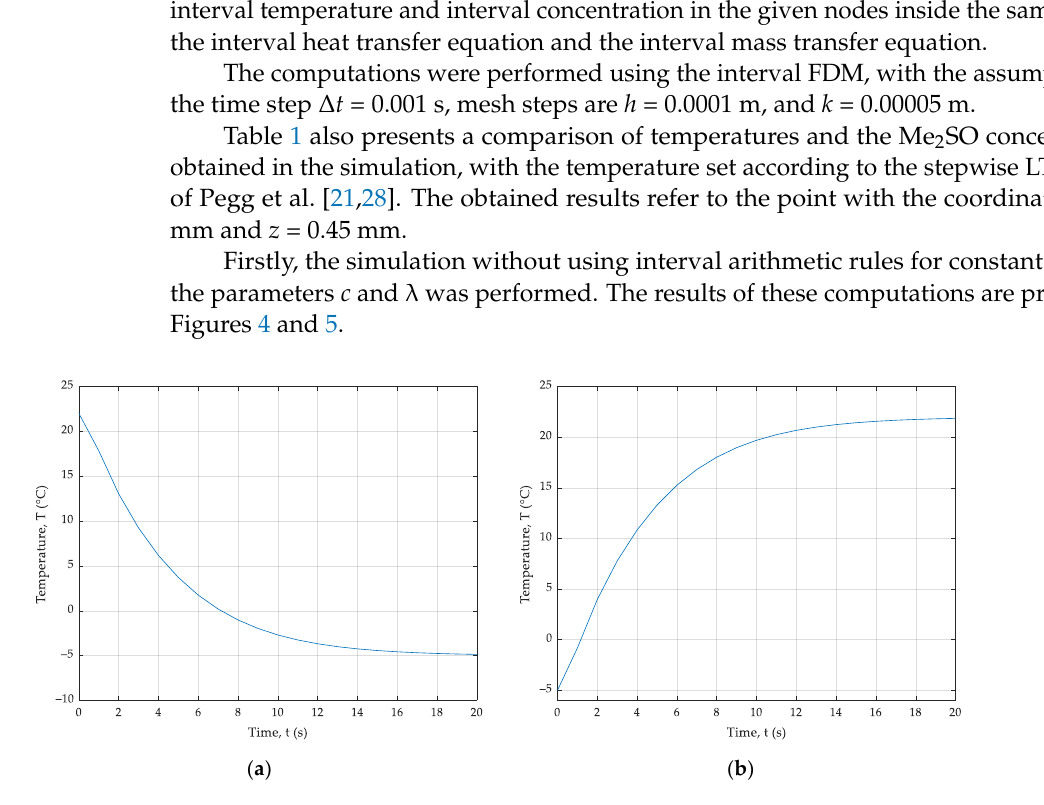
( a ) ( b ) Figure 5. History of the concentration over time without using interval arithmetic: ( a ) from 22 °C to −5 °C and ( b ) from −5 °C to 22 °C.